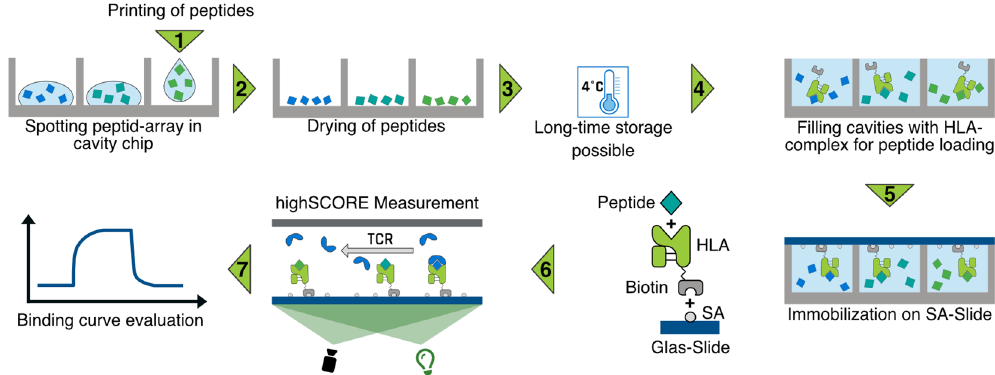
Figure 1. Different peptides are spotted into unique cavities of a microcavity chip (1). Peptide solution is dried out (2) and the arrays are ready for long time storage (3). To form the biomolecular complexes,